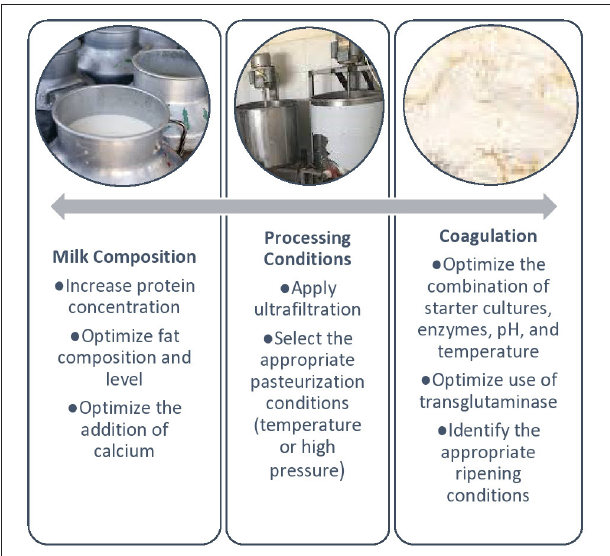
FIGURE 5 | Important considerations during the preparation of camel milk